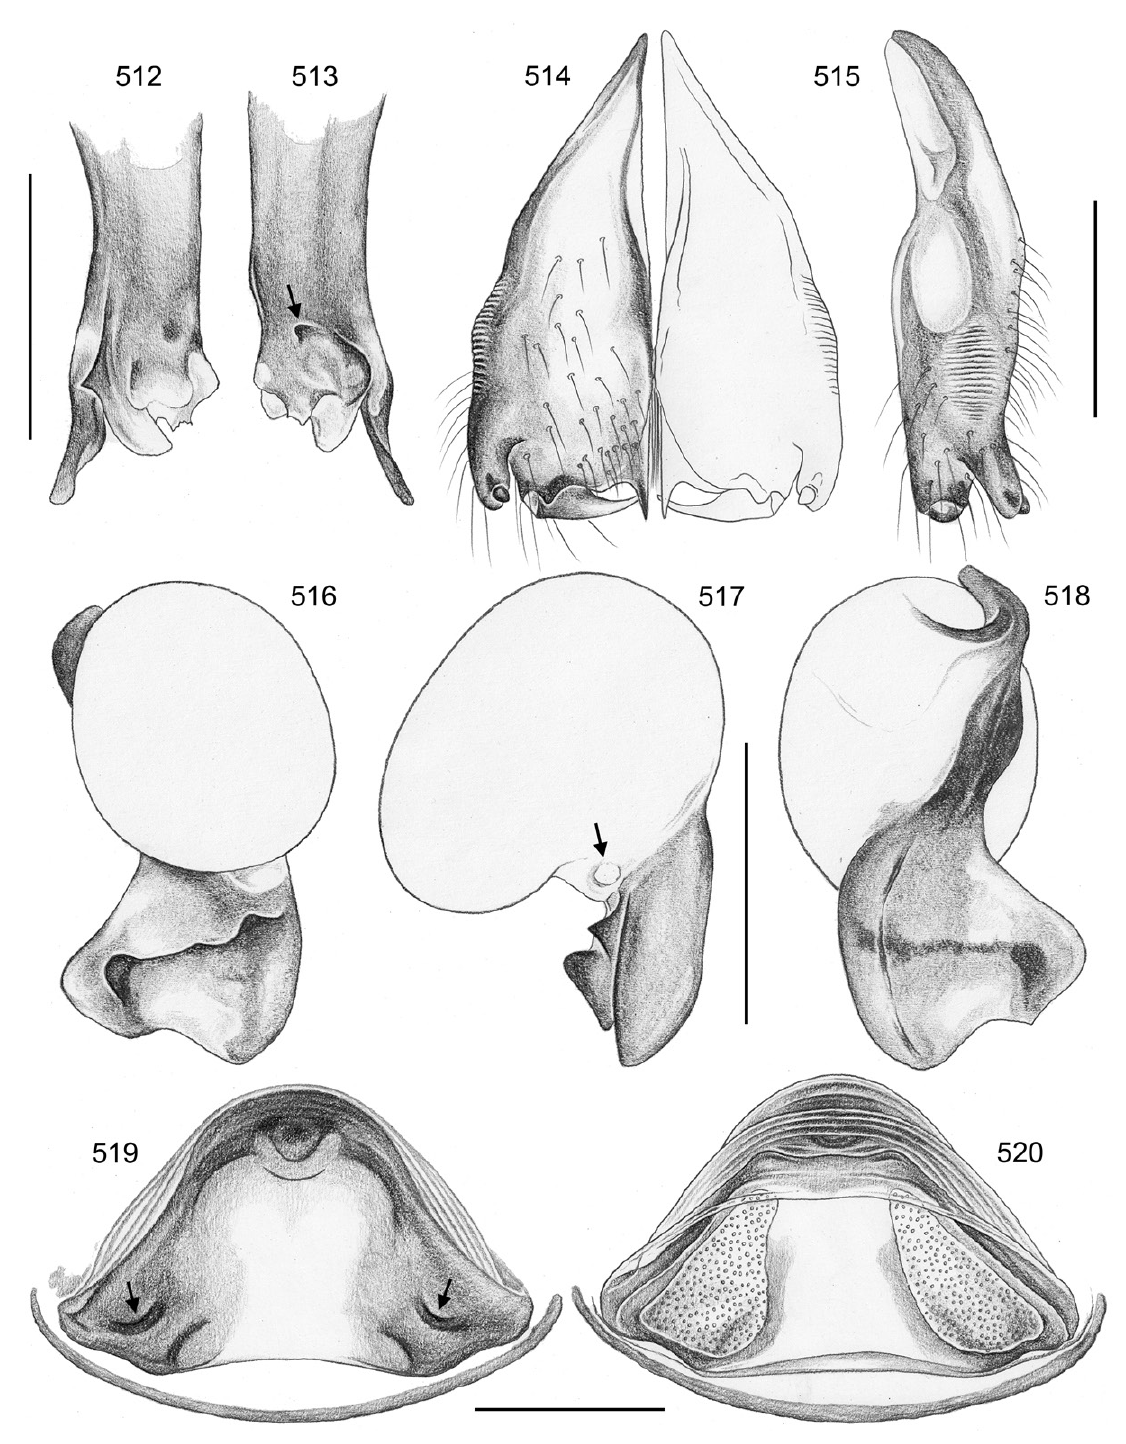
Figs 512–520. Crossopriza kittan sp. nov.; male and female from Oman, Al Kittan Cave (ZFMK Ar 22424, Ar 22425). 512–513 . Left procursus tip, prolateral and retrolateral views; arrow: distinctive retrolateral apophysis. 514–515 . Male chelicerae, frontal and lateral views. 516–518 . Left genital bulb, prolateral, dorsal, and retrolateral views; arrow: sperm duct opening. 519–520 . Cleared female genitalia, ventral and dorsal views; arrows: pockets. Scale bars: 512–513 = 0.2 mm; 514–520 = 0.3